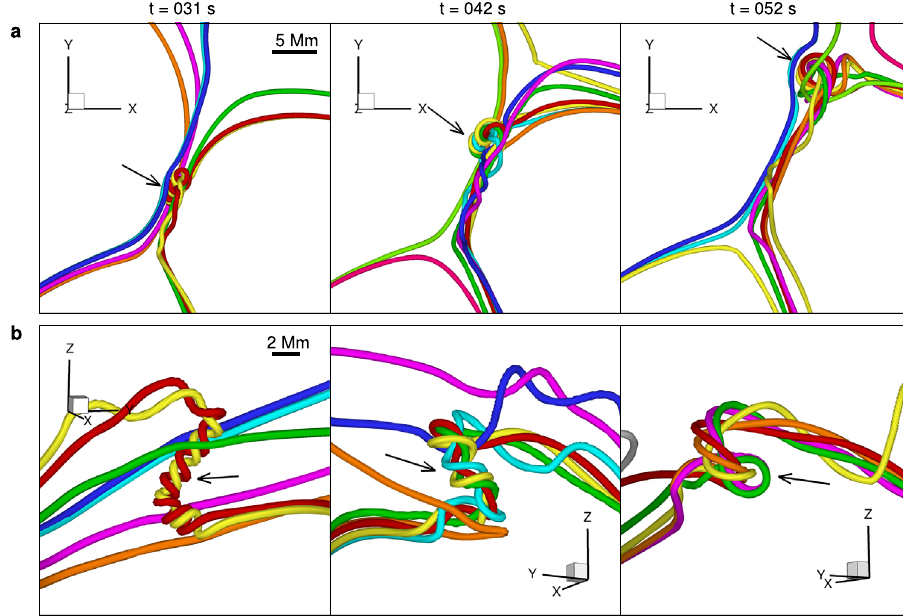
Fig. 10 Magnetic structure of the current sheet. a The corresponding magnetic structure of the current sheet. The black arrows indicate the magnetic structure of the biggest plasmoid. b 3D magnetic structure of the biggest plasmoid in a side view at three selected times. The arrows mark the heights given in panel b of Fig. 9. Note that the magnetic fi eld lines are shown by the thick colored lines, and the colors are used for a better visualization of the different